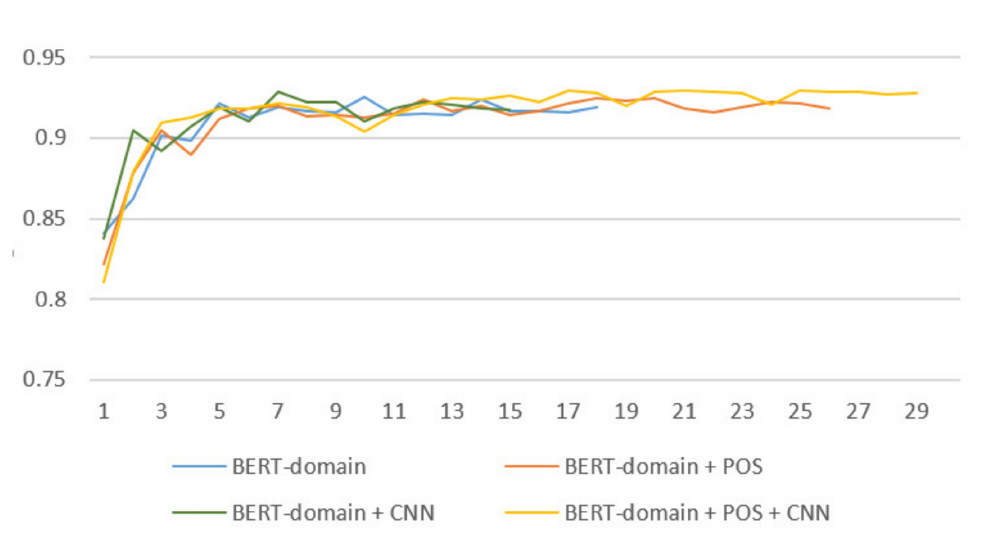
Figure 6. Model training with different embedding